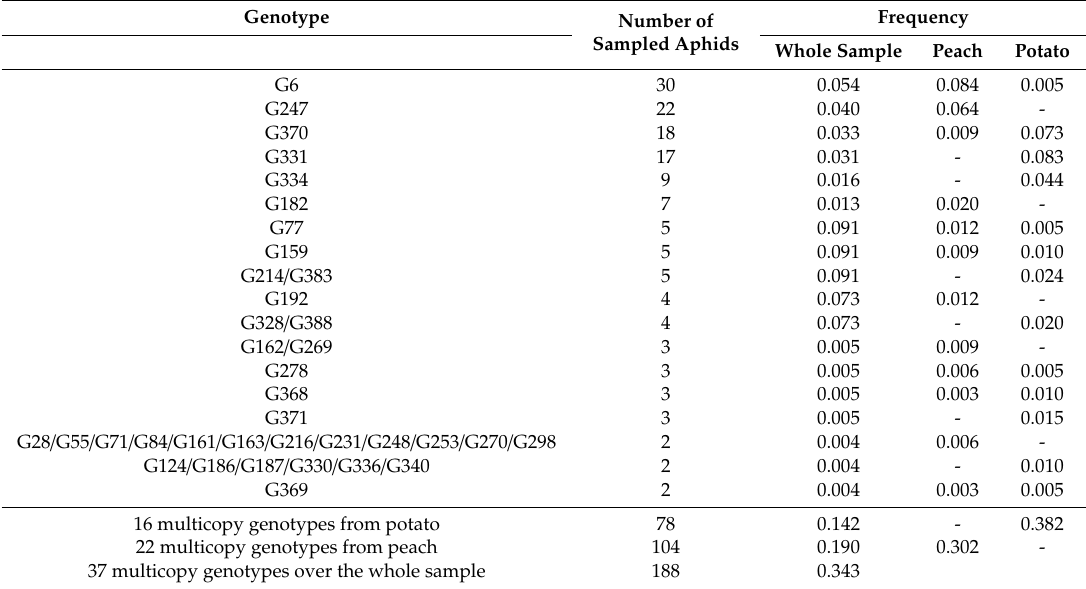
Table 3. Frequency of each multicopy genotype in the whole sample and according to the host plant where M. persicae aphids were